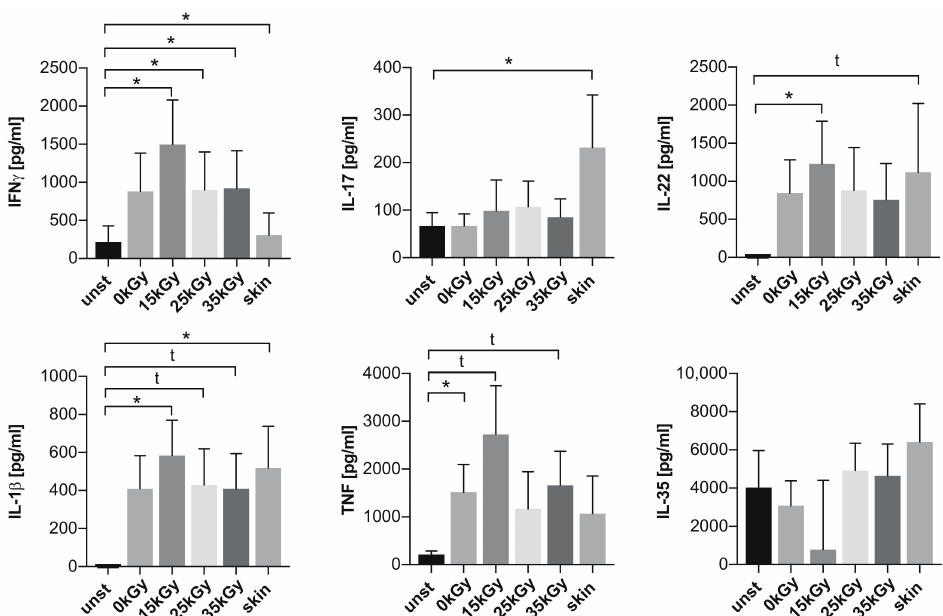
Figure 5. Summary of analyses of immunomodulatory properties of irradiated scaffolds. The levels of IFN γ , IL-17, IL-22, IL-1 β , TNF, and IL-35 in cell culture supernatants from peripheral blood mononuclear cell alone (unst) or co-incubated with irradiated (15 kGy, 25 kGy, 35 kGy) hADM, non-irradiated (0 kGy) hADM, or unprocessed skin. n = 5; * p < 0.05; t trend at the threshold of statistical significance (0.1 > p >